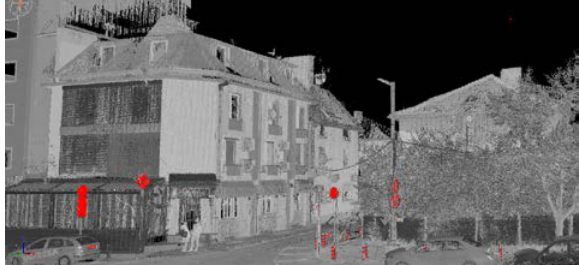
Figure 21: Buildings 3 and 4 in a parcel 68134.902.235 – point cloud